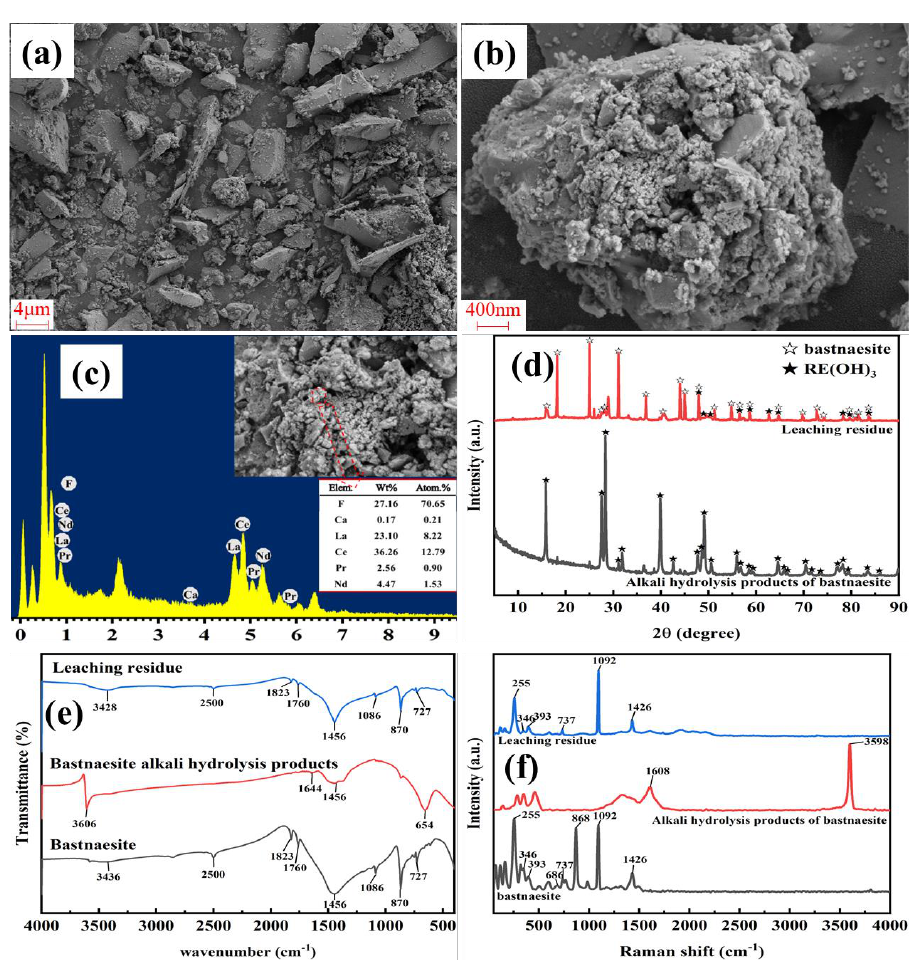
Figure 8. SEM-EDS analysis results of leaching residue ( a – c ), the XRD ( d ), FITR ( e ), and Raman spectra ( f ) of bastnaesite, alkali hydrolysis products of bastnaesite, and leaching residue.